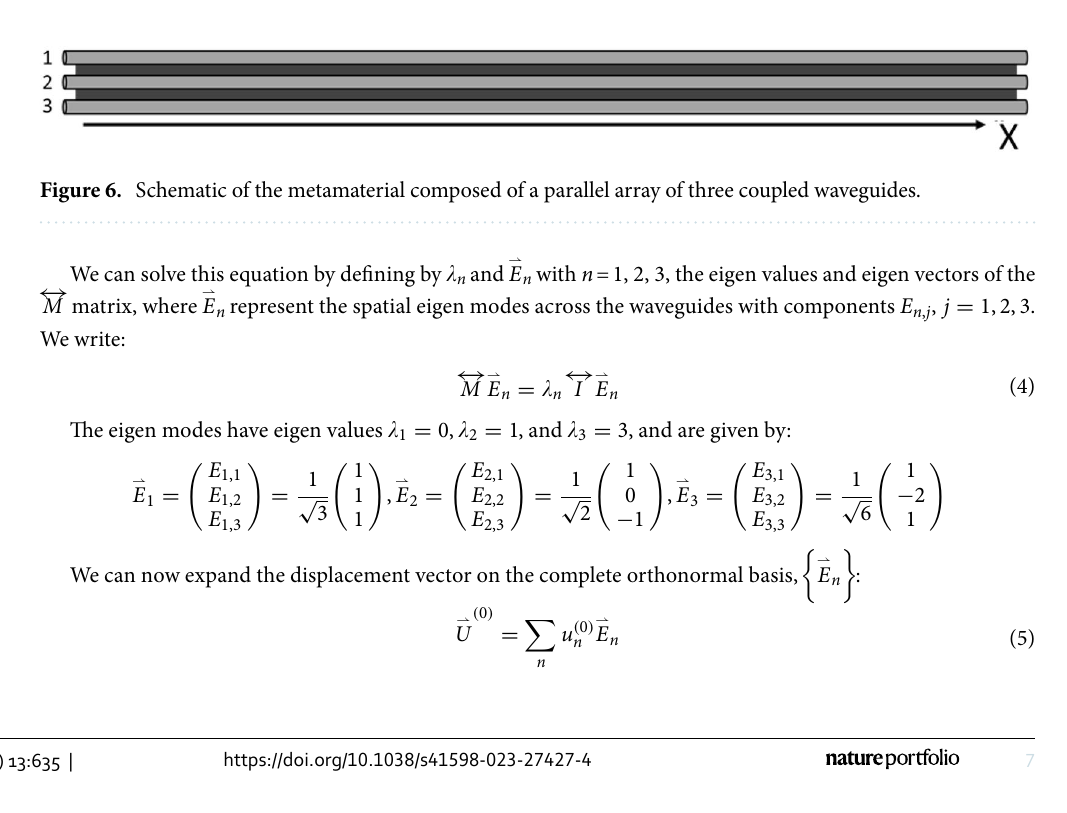
1 f 2 (top) and 4 f 1 2 f 2 (bottom) as a function of frequency f 1 tuned Figure 5. Phase ϕ 13 for two phi-bits 3 f 1 − − downward or upward. The closed circles correspond to the conditions when f 1 is decreased by increments of 66kHz . The open circles 10 Hz from 59.6kHz to 58.8kHz and the second driving frequency is fixed at f 2 = correspond to f 1 increasing by increments of 10 Hz from 58.8kHz to 59.6kHz and the second driving frequency 66kHz . The origin of the spikes near 59.4 kHz is unknown. remaining fixed at f 2 =